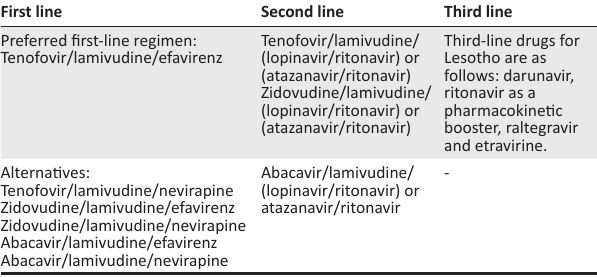
TABLE 1: Recommended antiretroviral treatment regimens for adolescents and adults in